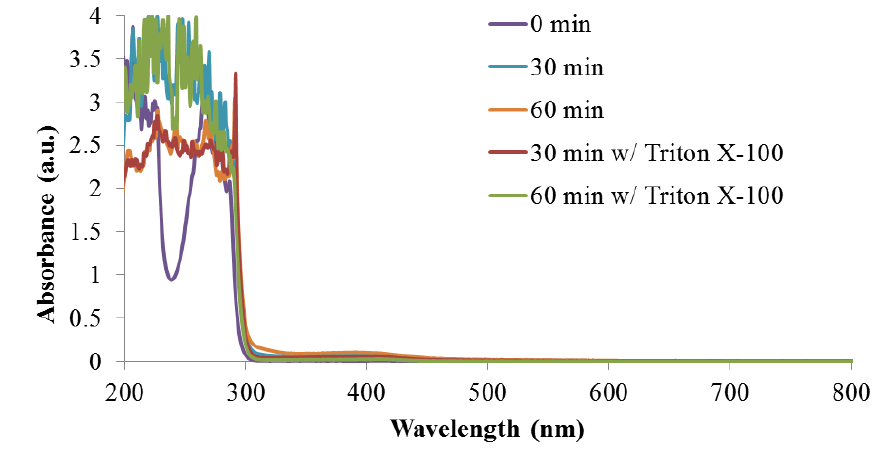
Figure A4. Full absorbance spectra monitoring of reaction with and without Triton X-100.